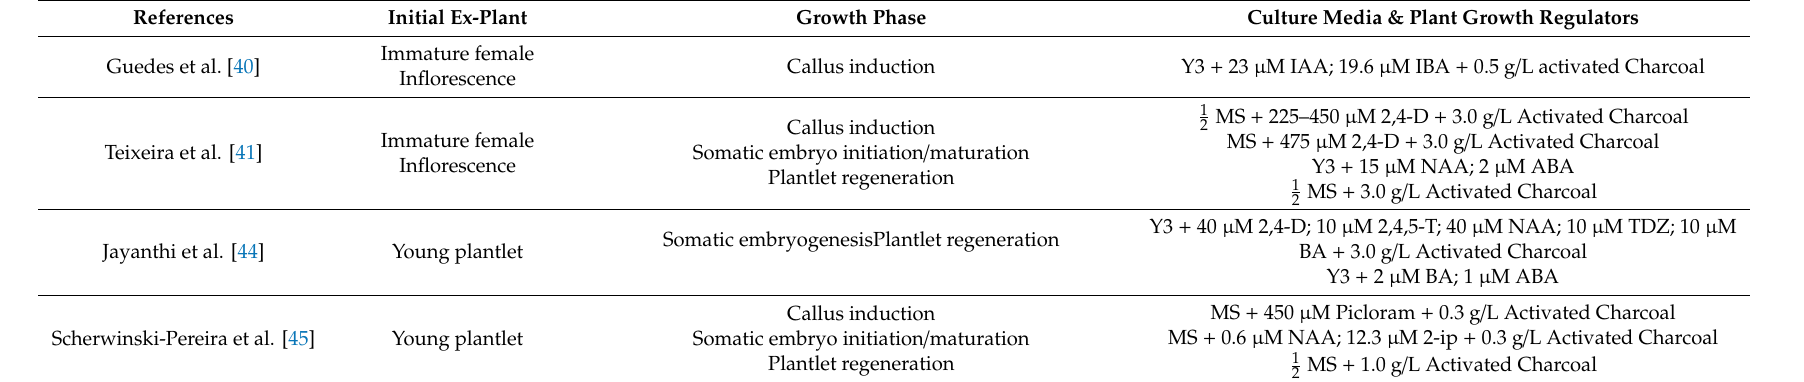
Table 2. In vitro regeneration of oil palm via somatic